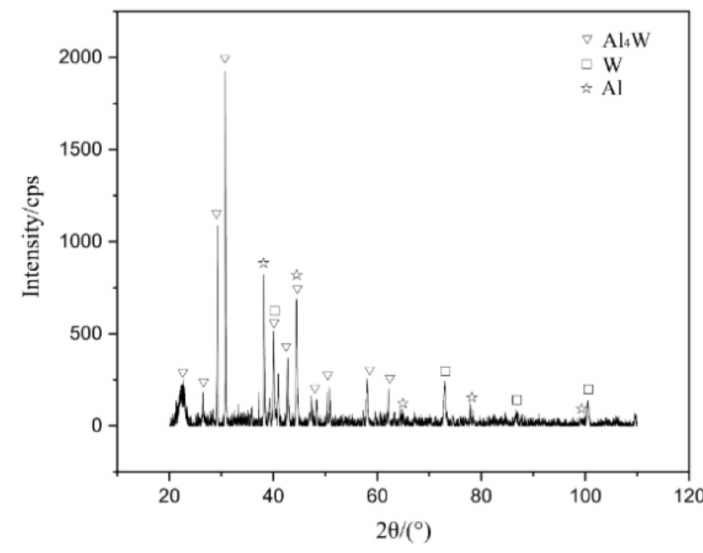
Figure 5. X-ray diffraction spectrum of the W/Al composite